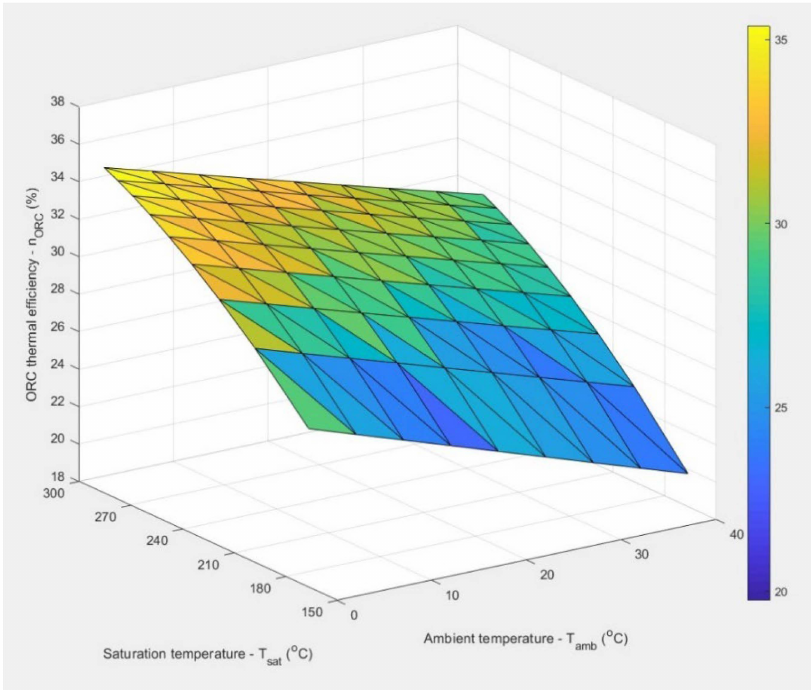
Figure 5. ORC thermal efficiency as a function of the evaporator saturation temperature and the ambient